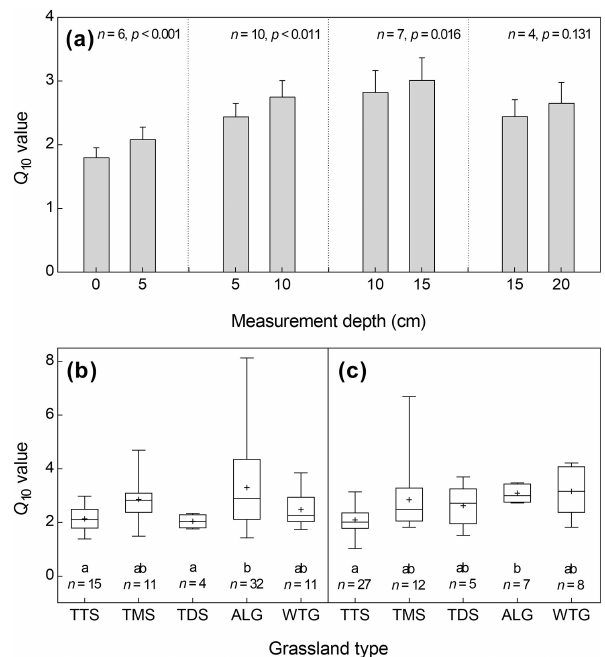
Figure 4. Comparisons of Q 10 values among soil temperature mea- surement depths (a) and among grassland types (b, c) . (a) Q 10 values derived by soil temperature at depths of 0, 5, 10, 15, and 20cm, respectively. (b) Q 10 values derived by soil temperature at a depth of 5cm. (c) Q 10 values derived by soil temperature at a depth of 10cm. TTS, TMS, TDS, ALG, and WTG represent tem- perate typical steppe, temperate meadow steppe, temperate desert steppe, alpine grassland, and warm, tropical grassland, respectively. Error bars in (a) represent standard errors. In the box plot (b, c) , the “ + ” symbols represent mean values, horizontal lines inside box represent medians, box ends represent the 25th and the 75th quar- tiles, vertical lines represent 2.5th and 97.5th percentiles, and n represents the number of samples. Different lowercase letters in- dicate significant differences among soil depths or grassland types at p = 0 .